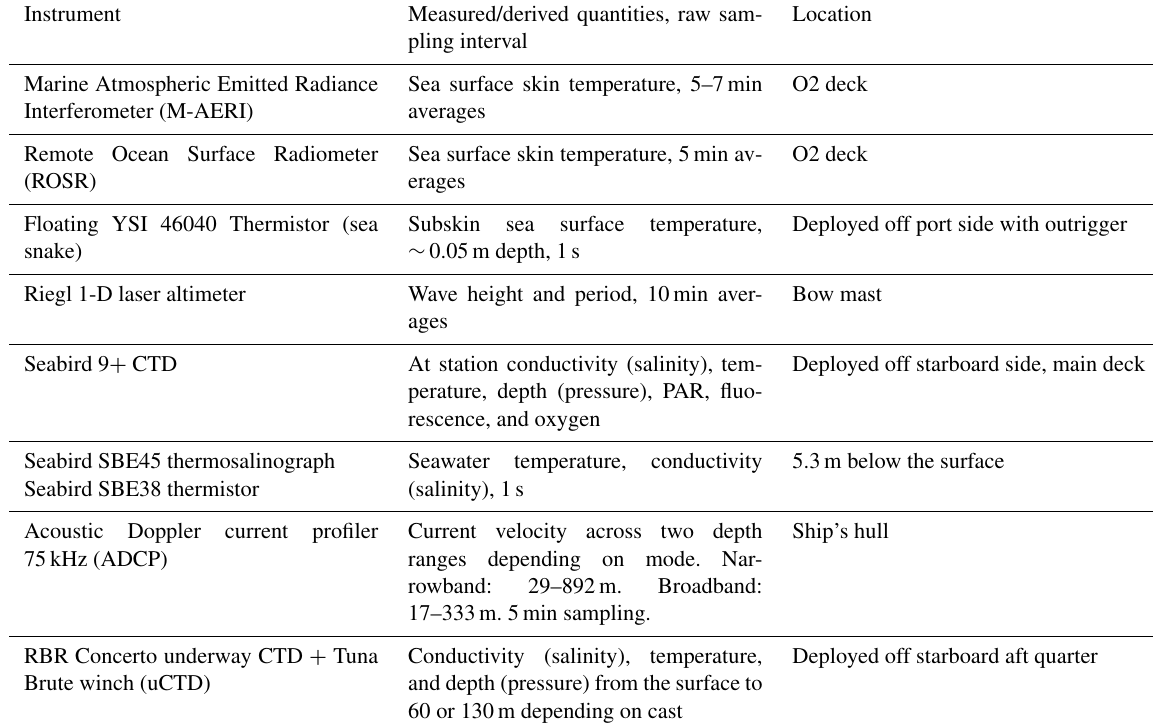
Table 6. Instrumentation on board the RV Ronald H. Brown for the measurement of seawater parameters. O2 deck is two levels above the main